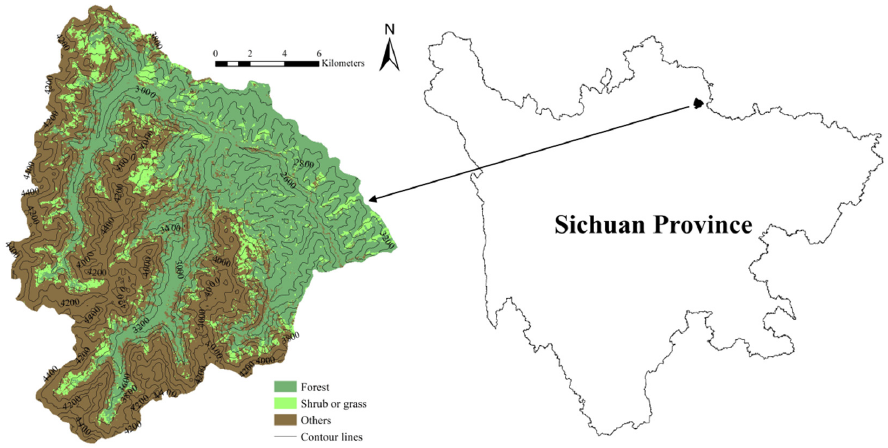
Figure 1. The location and forest cover type distribution map of Wanglang Nature Reserve.